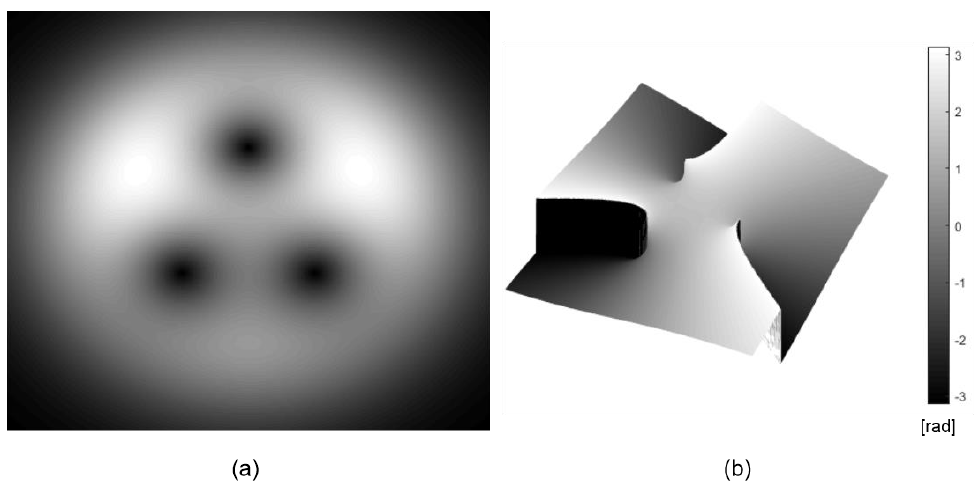
Figure 2. Vortex beam with a topological charge of m = 3 after separation into three vortices with topological charges of m = 1: ( a ) intensity, ( b ) phase profile.